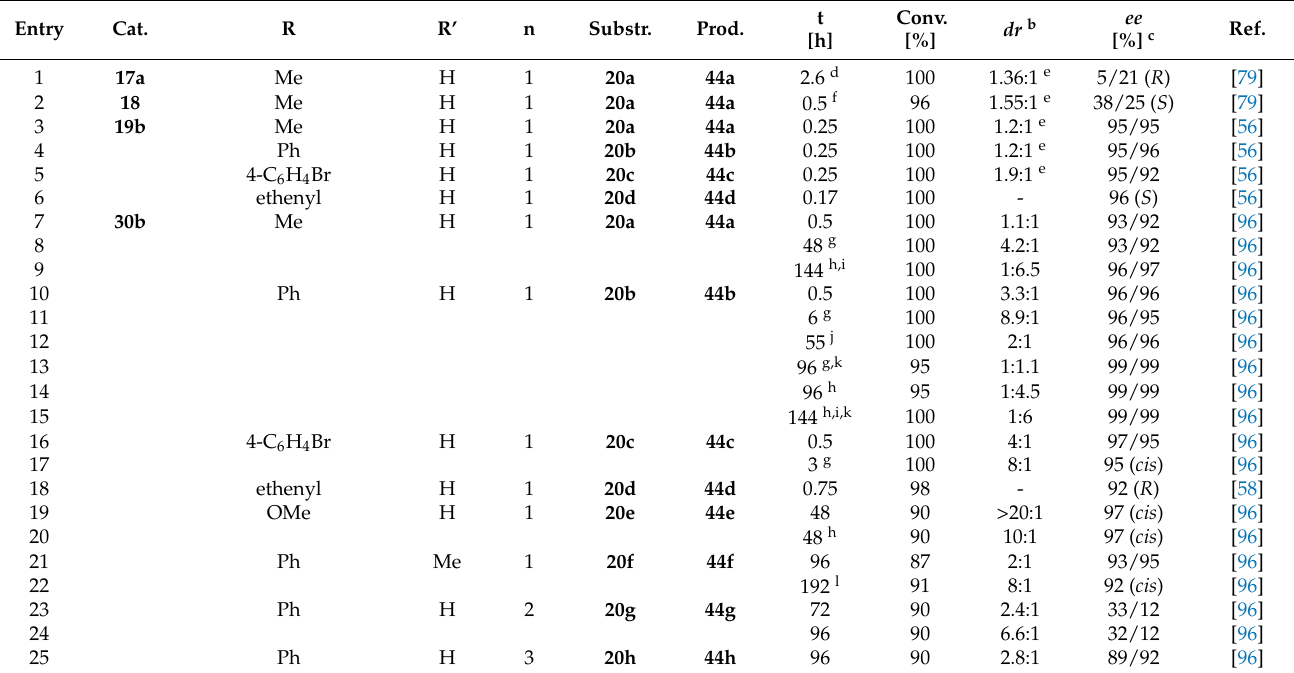
Table 11. Catalytic asymmetric hydroamination of 20a – h and 45a – c using chiral catalysts 17a , 18 , 19b , 30b , c and 31 a